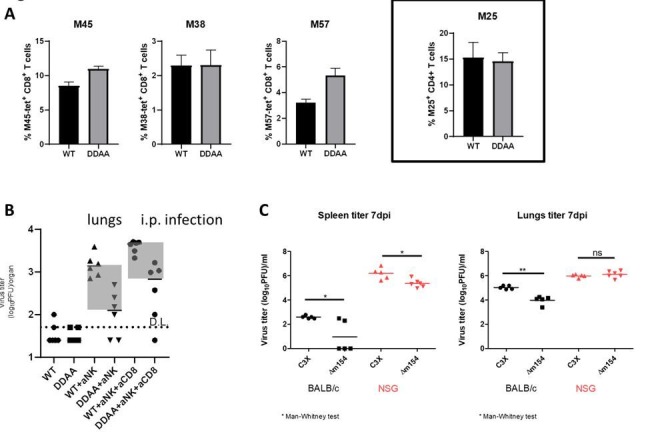
Effect of m154 distruption on immune control mediated by other immune cell populations.(A) 105 of M25-II TCR-transgenic CD4+ T cells (CD45.1+) were adoptively transferred into Ly49H-/- C57BL/6 mice (CD45.2+). One day following adoptive transfer mice were i.v. infected with 2x105 PFU of WT MCMV or m154-DDAA mutant. 7 days after infection the frequency of virus-specific splenic CD8+ T cells was determined by tetramer staining (left panels; M45, M38 and M57) and flow cytometry. The frequency of M25-II positive cells was determined by analysis of CD45.1 expression (right panel). (B) C57BL/6 mice were infected with 2x105 PFU of WT MCMV or m154-DDAA mutant. NK and CD8+ T cells were depleted where indicated by the use of monoclonal antibodies. On day 7 p.i. viral titers in lungs of individual mice (circles, squares) were determined by standard plaque assay. (C) Balb/c and NSG mice were infected with 2x105 PFU of WT MCMV or Δm154 mutant. On day 7 p.i. viral titers were determined as described in B. Horizontal bars indicate the median values. DL, detection limit. Two-tailed Mann-Whitney test was used to assess statistical differences between experimental groups. For each group of mice in B) n=6 and in C) n=5.